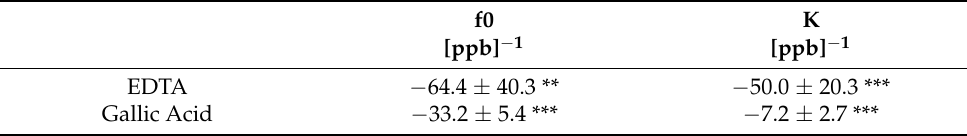
Table 2. Two ways analysis of covariance (ANCOVA) results, after log-transformation. The reported values in this table represent the regression coefficients of the ANCOVA model [ppb] − 1 , which can be interpreted as the effect size of each antioxidant (AO) on the response parameters f0 and K. f0 [ppb] − 1